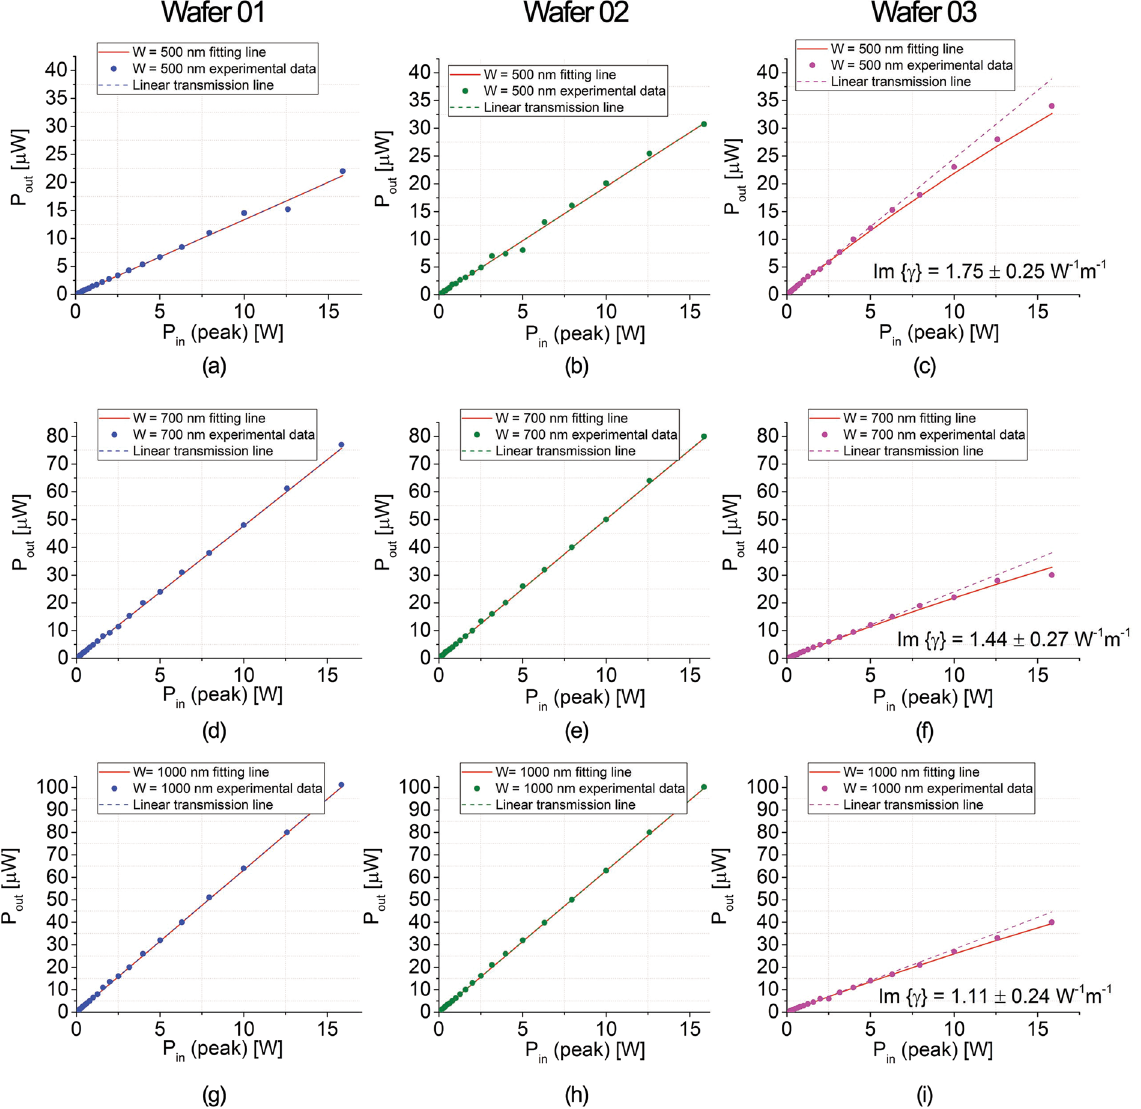
Figure 9. Pulsed transmission graph for Wafer 01 (( a ) W = 500 nm, ( d ) W = 700 nm and ( g ) W = 1000 nm), Wafer 02 (( b ) W = 500 nm, ( e ) W = 700 nm and ( h ) W = 1000 nm) and Wafer 03 (( c ) W = 500 nm, ( f ) W = 700 nm and ( i ) W = 1000 nm).